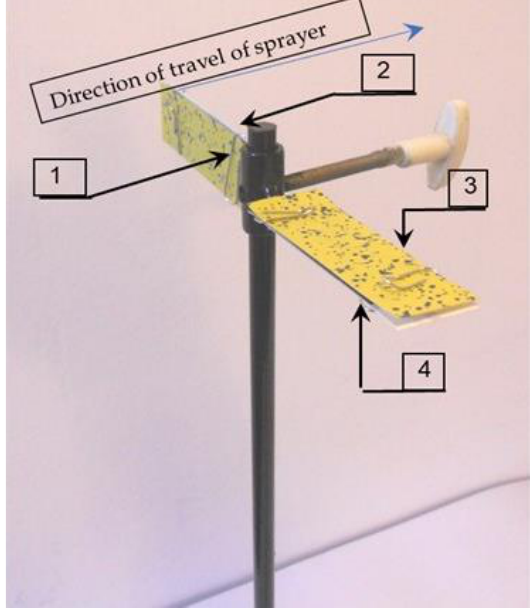
Figure 2. Artificial plant with water-sensitive papers: 1 — vertical approach surface, 2 — vertical leaving surface, 3 — horizontal upper surface, 4 — horizontal bottom surface.